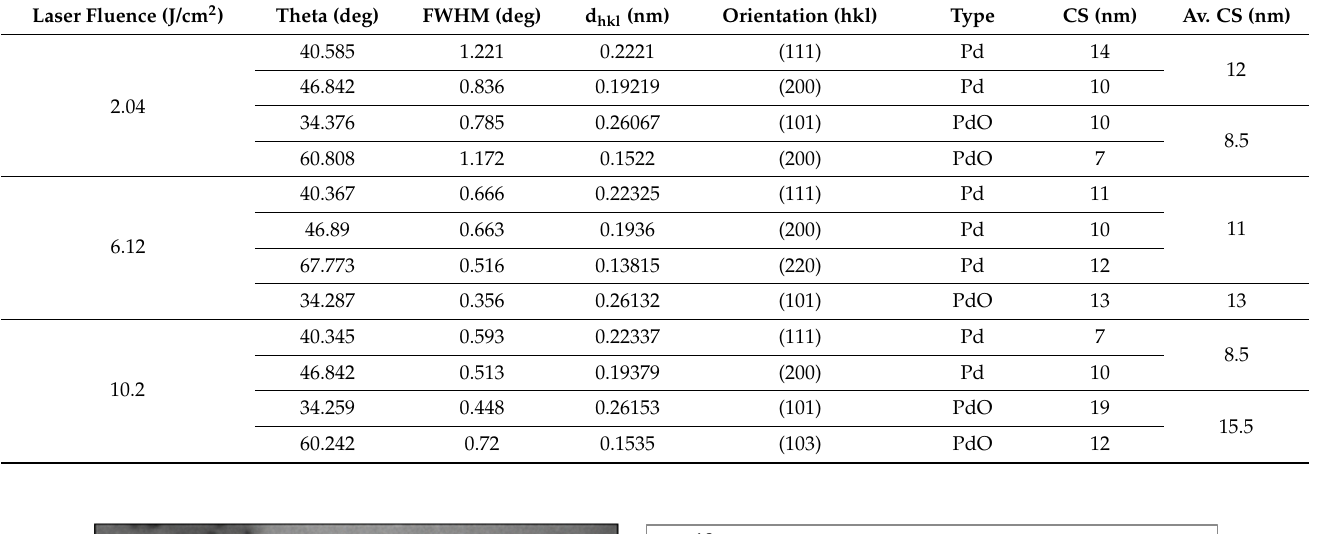
Table 1. The crystalline size (CS) of palladium nanoparticles (Pd NPs) prepared by 1064 nm laser ablation of palladium target in distilled water with different fluences 2.04 J/cm 2 , 6.12 J/cm 2 , and 10.2 J/cm 2 at 100 pulses.